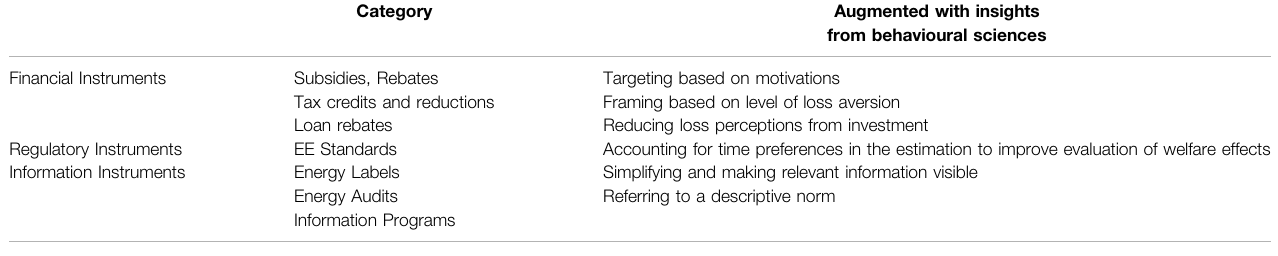
TABLE 2 | “ Summary of Traditional Interventions promoting EE adoption ” .